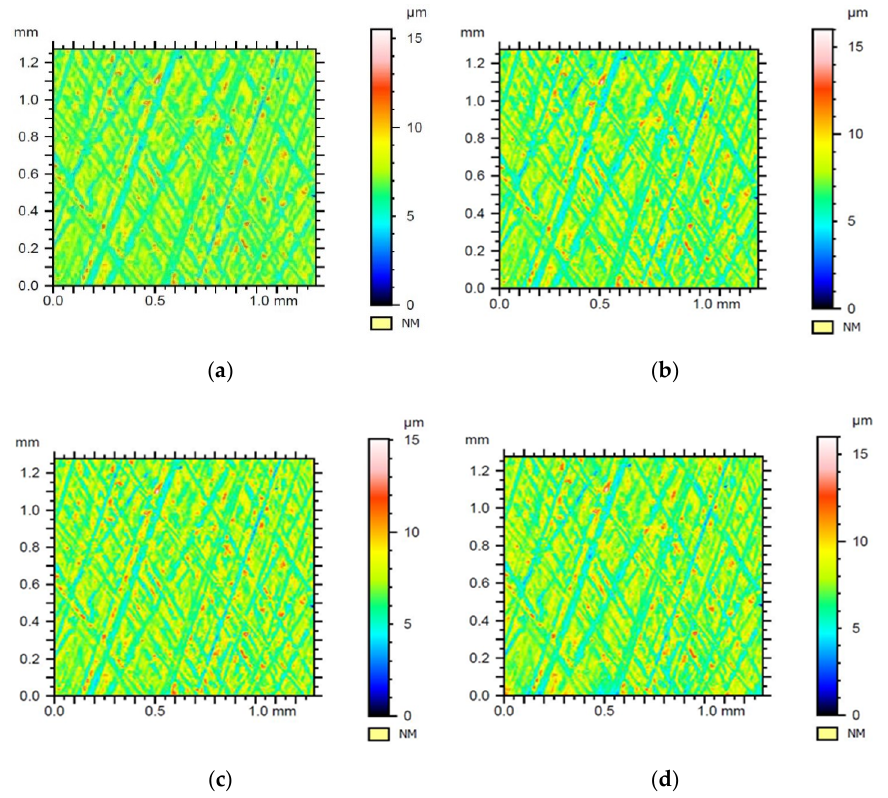
Figure 18. The surfaces of sample no. 2 with a flat-top structure after its leveling, shape removing, and applying: ( a ) Gauss filtering, ( b ) Daubechies wavelet, ( c ) Morlet wavelet, ( d ) Mexican hat wavelet.